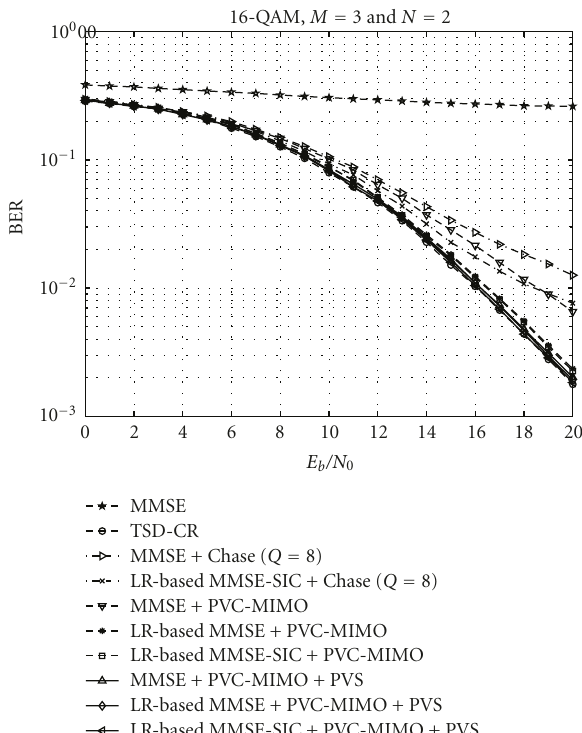
Figure 3: BER versus E b /N 0 of di ff erent detectors represented in Section 5.1 for 16-QAM, M = 3, N =